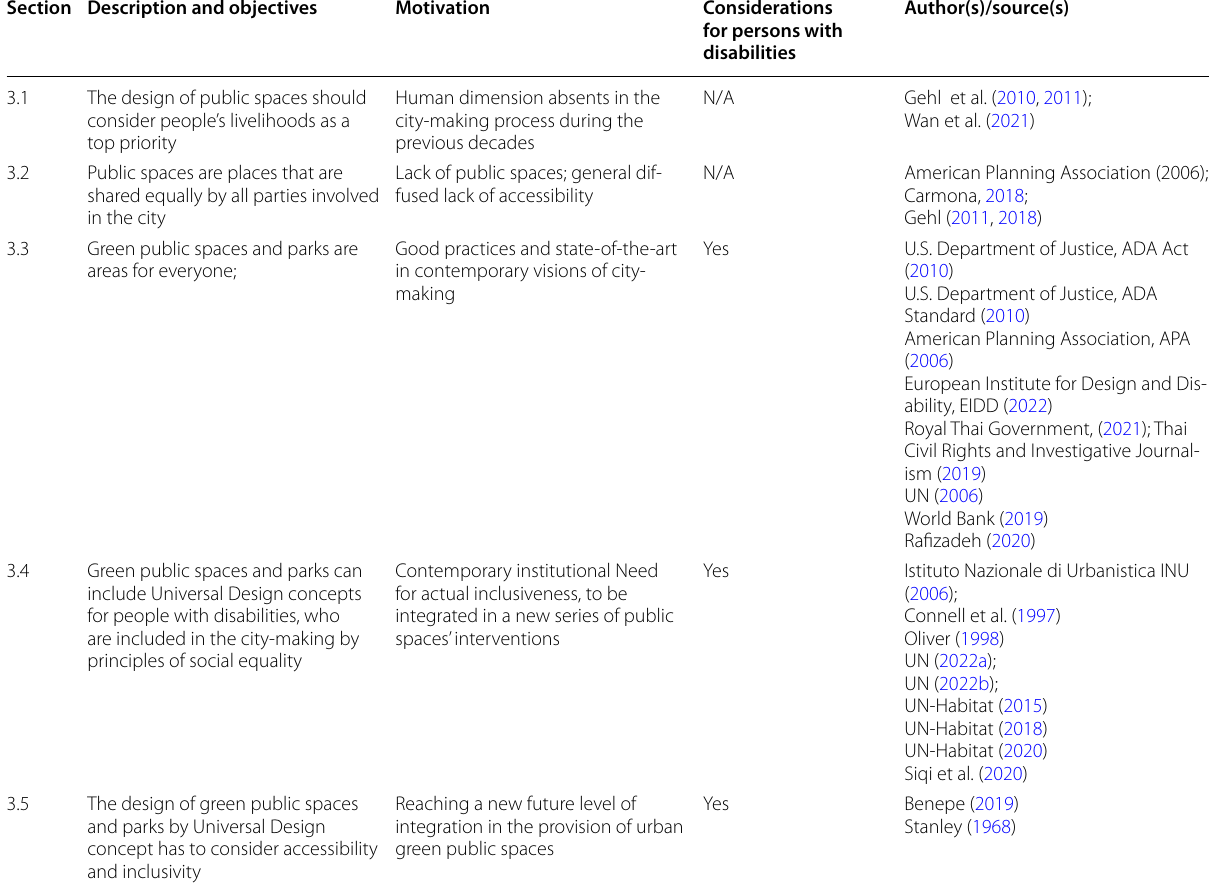
Table 1 Summary of academic concepts related to public space design. Sources: Researcher Team, 2022 Section Description and